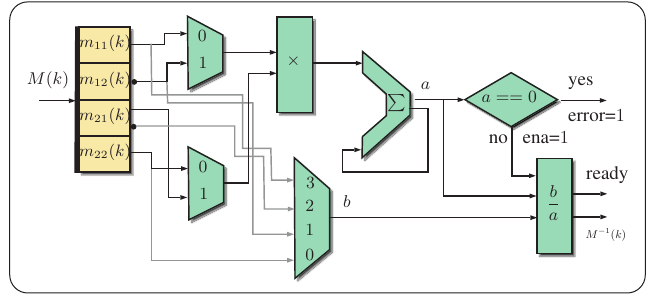
Figure 10. Matrix inverse